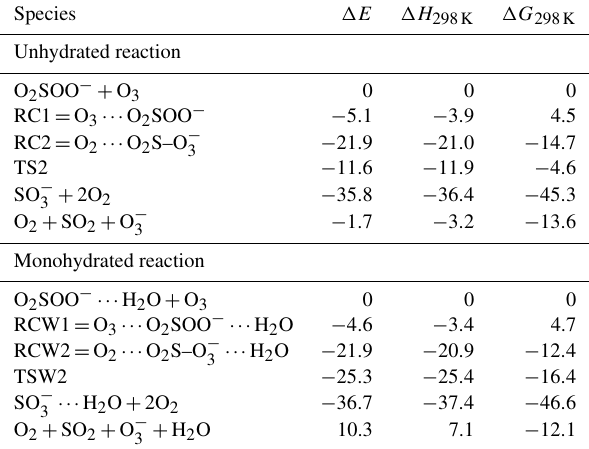
Table 1. Electronic energies ( (cid:49)E ), enthalpies ( (cid:49)H 298K ), and Gibbs free energies ( (cid:49)G 298K ) of the different states in the O 2 SOO − + O 3 reaction both in the absence and in the presence of water, calculated relative to the energy of initial reactants at the UCCSD(T)/aug-cc-pVTZ//UM06-2X/aug-cc-pVTZ level of theory. Species (cid:49)E Unhydrated reaction